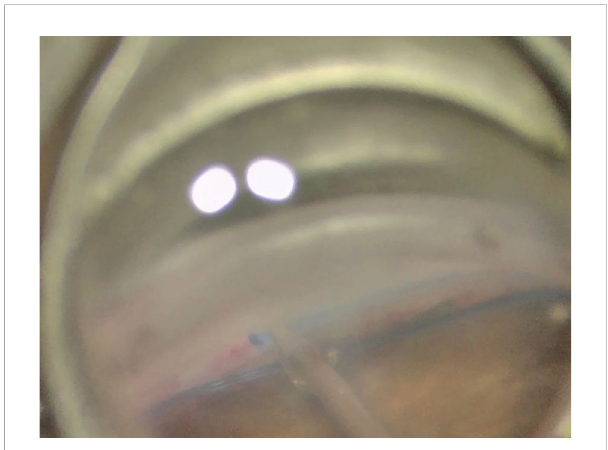
FIGURE 6 Pulling of the distal part of 5-0 Prolene suture after Schlemm canal is cannulated circumferentially during GATT